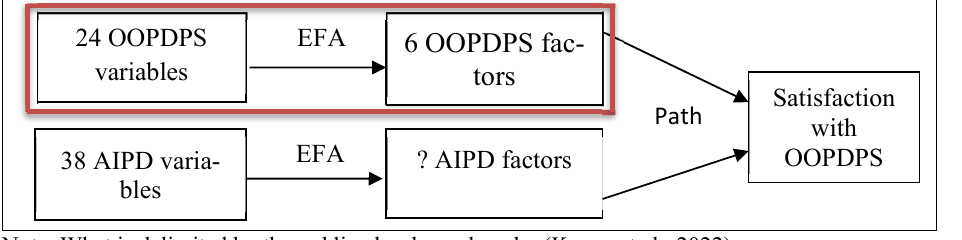
Fig. 4. Data Analysis Framework